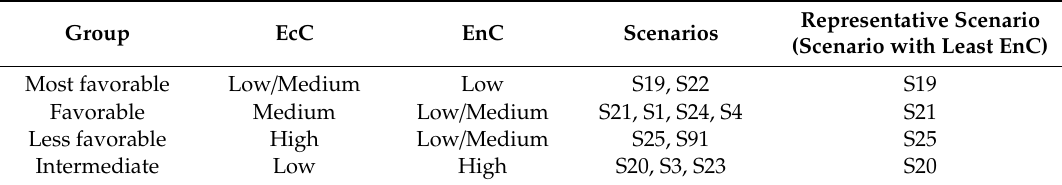
Table 8. Groups of acceptable scenarios.